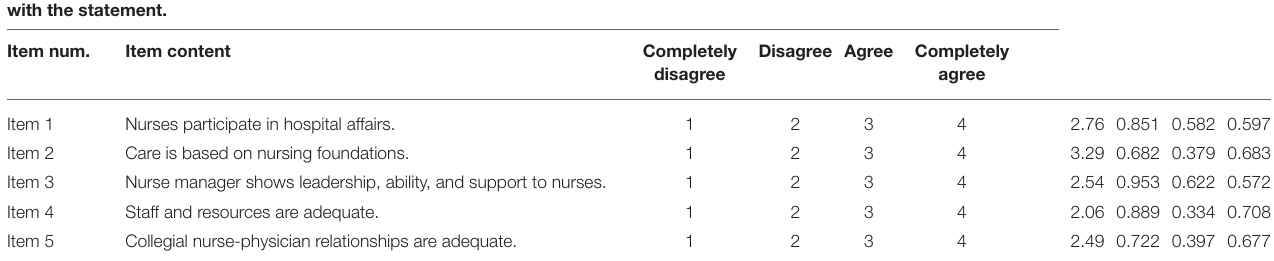
TABLE 1 | The brief nurses’ practice environment scale (BNPE scale). Instructions: mark the degree to which you agree with the following statements regarding your work environment. Take into account that 1 implies that you totally disagree with the proposed sentence and 4 means that you completely agree with the